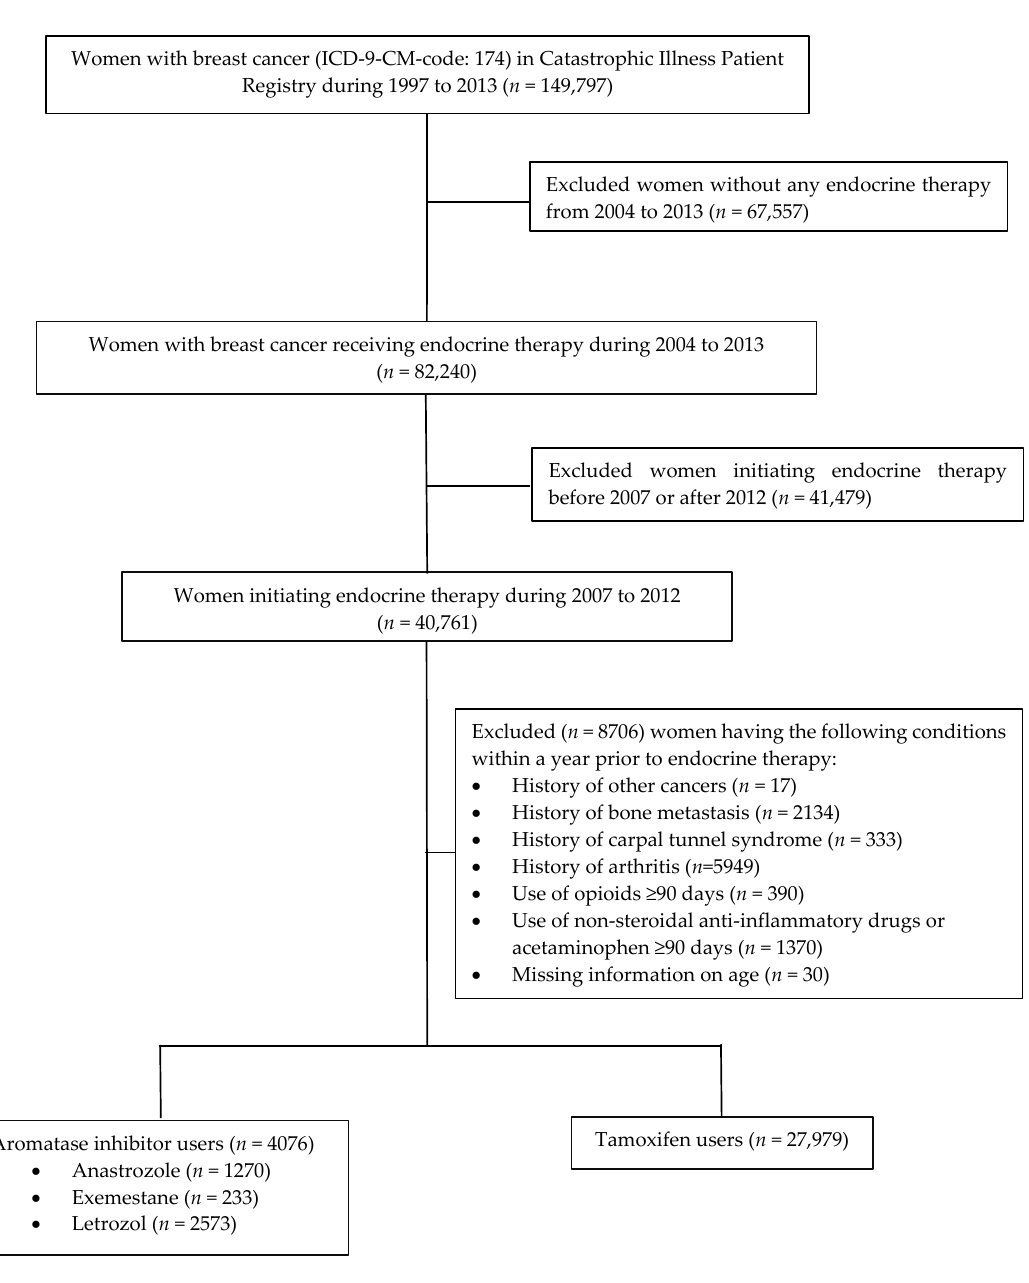
Figure 1. Selection of Analytical Cohort Flow Chart.